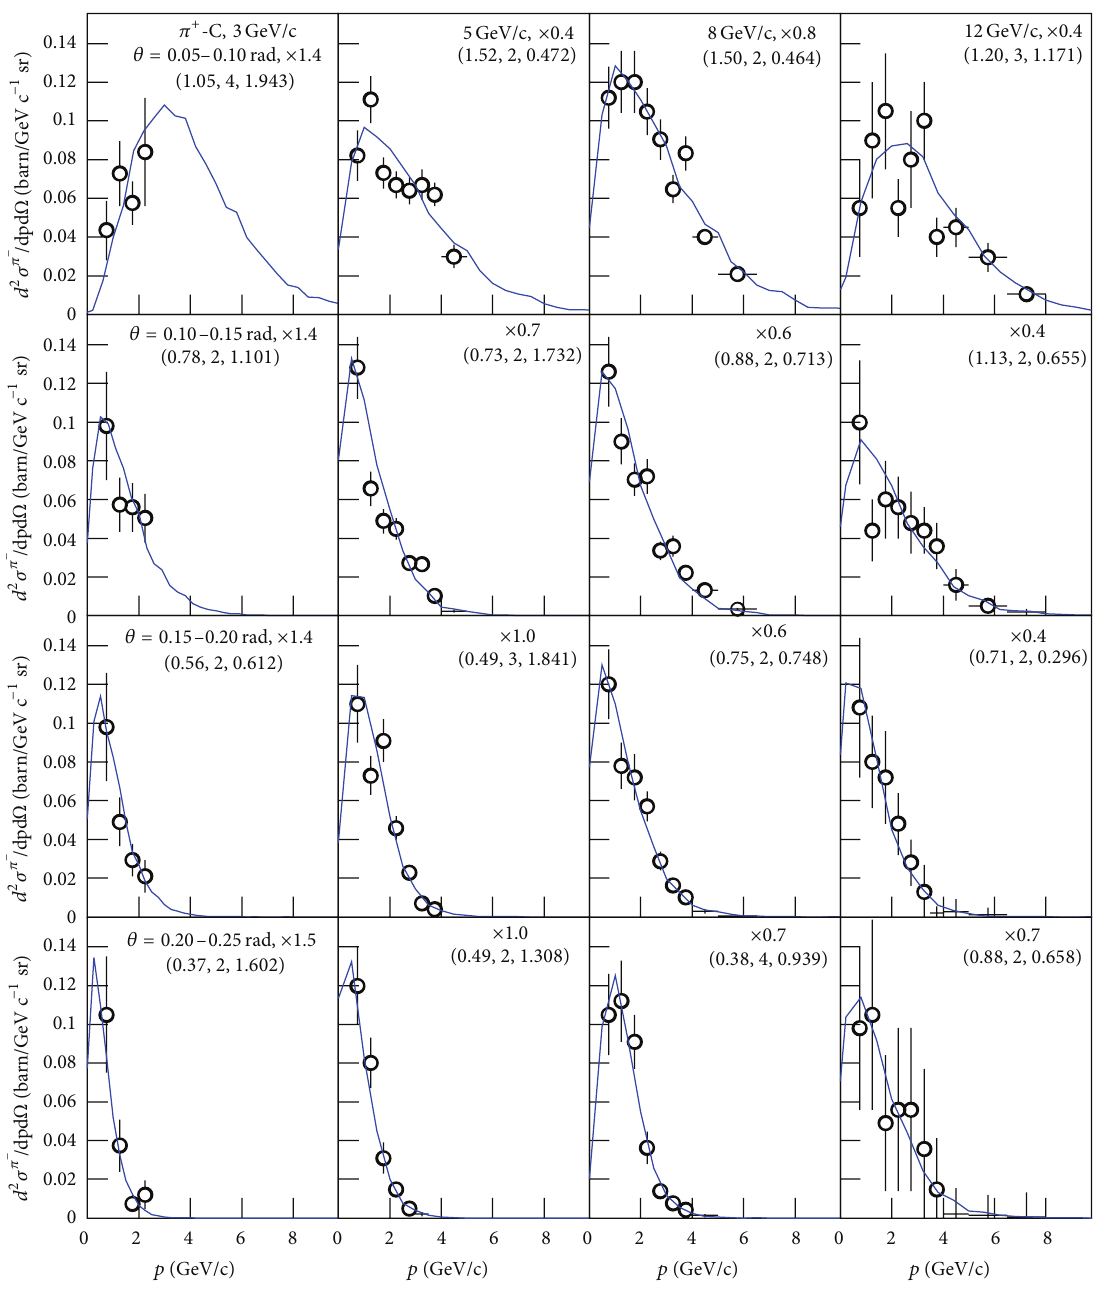
Figure 8: The same as Figure 1, but showing the results for 𝜋 − production cross sections in 𝜋 + -C interactions.